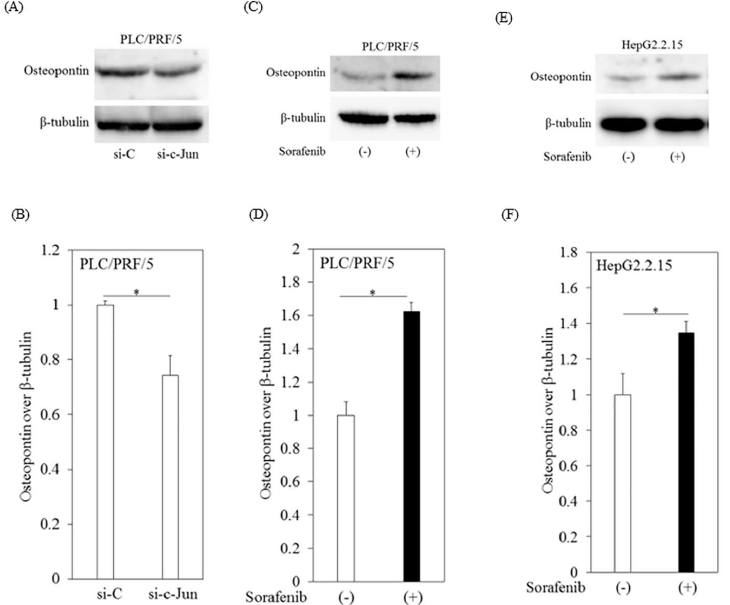
Fig 7. Sorafenib enhanced expression of osteopontin, an AP-1 target gene, in human hepatoma cell lines. (A, B) Knockdownof c-Jun decreased expressionof osteopontin after 48 hours of transfectioninto PLC/PRF/5 cells with siRNA against c-Jun (si-c-Jun) or si-control (si-C). Lysates from transfected cells were immunoblotted with antibodies againstosteopontinor β -tubulin. β -tubulin was used as internalcontrol. (C, D) Western blot analysesof osteopontin and β -tubulin expressionin PLC/PRF/5 cells treated with or without 10 μ M sorafenibfor 12 hours. (E, F) Western blot analysesof osteopontin and β -tubulinexpressionin HepG2.2.15 cells treated with or without 10 μ M sorafenibfor 12 hours. Densitometric analyseswere performed with ImageJ software. Data are presented as mean ± SD of triplicate samples. * p < 0 . 05 between two